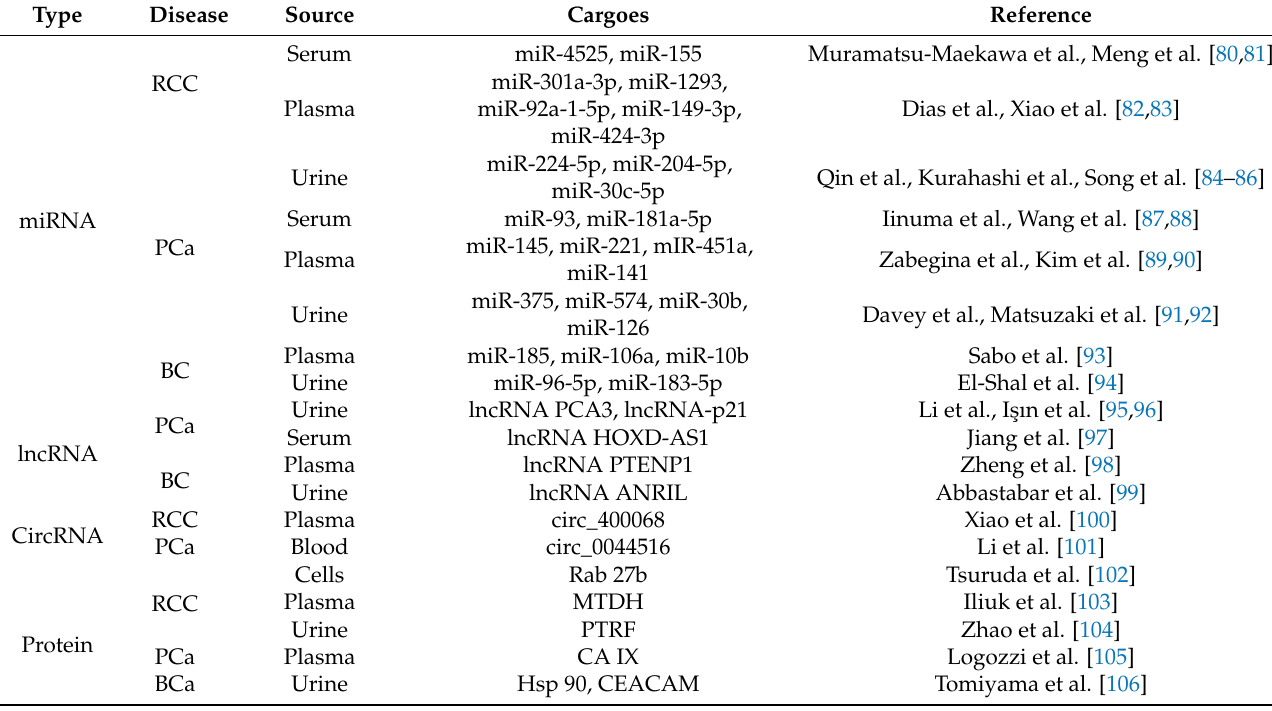
Table 2. Possible candidate markers of EVs in Urological